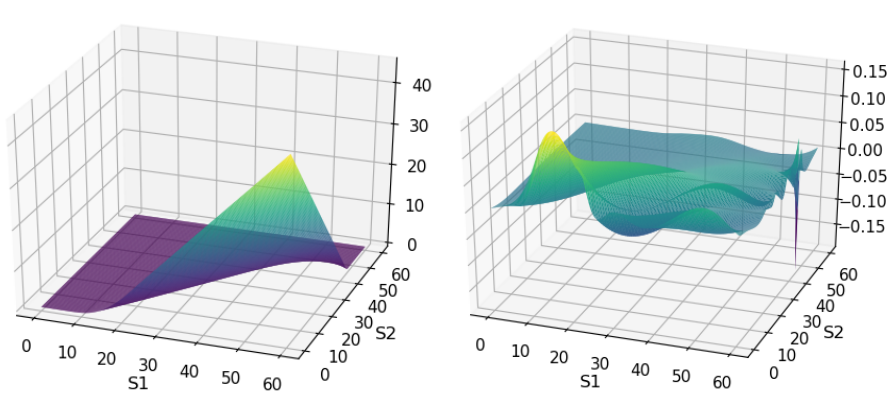
Figure 7. Two-asset spread American option value in the whole domain ( left ). Error surface between the FEM and the ANN solution ( right ).